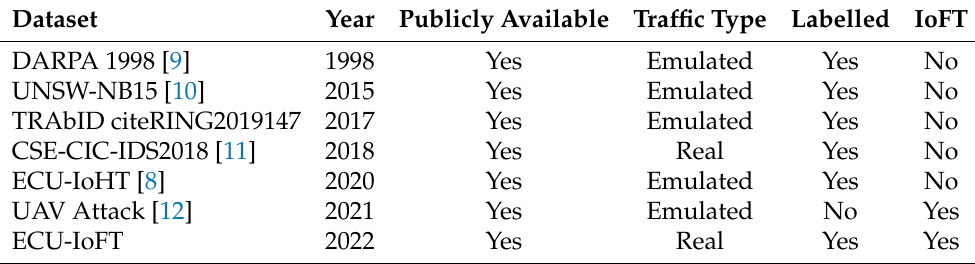
Table 1. IDS Dataset Comparison.